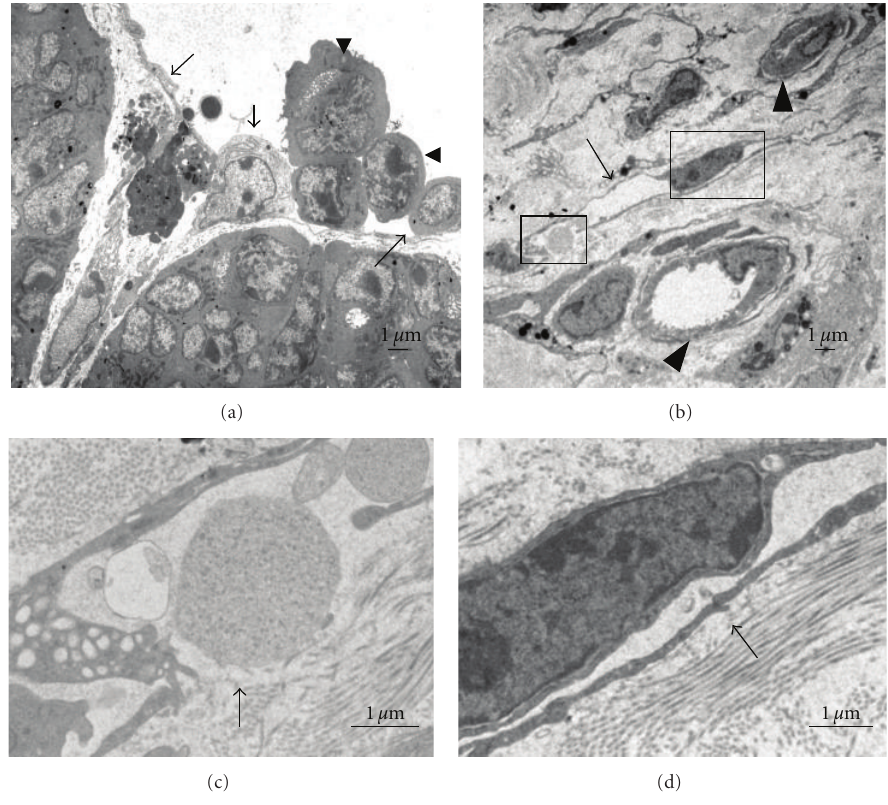
Figure 6: TEM micrographs of lymphatic vessels in BJMC3879 tumors at 10 weeks postinoculation (a) and 4 weeks postinoculation (b). The boxed areas in (b) are observed with high-power view (c and d). (a) A leukocyte ( ∗ ) is seen between endothelial cells (arrows), whereas tumor cells (arrowheads) are observed in the lumen. (b) Lymphatic capillary (arrow) and blood capillaries (arrowheads) are detected in the connective tissue surrounding tumors. Casein-like droplet (arrow) is located in the opening junction (c), and characteristic over-lapping junction (arrow) is showed